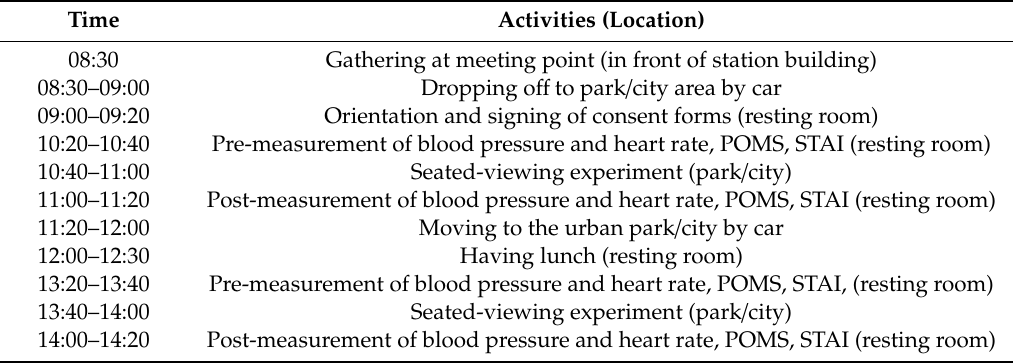
Table 3. Time schedules during the viewing experiment of park therapy in spring and early summer. POMS: Profile of Mood States; STAI: State-Trait Anxiety Inventory. Time Activities (Location) 08:30 Gathering at meeting point (in front of station